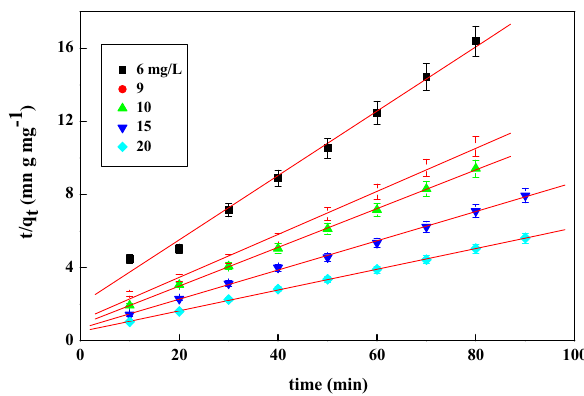
Fig. 9 Pseudo-second biosorption kinetics of preatreated coffee